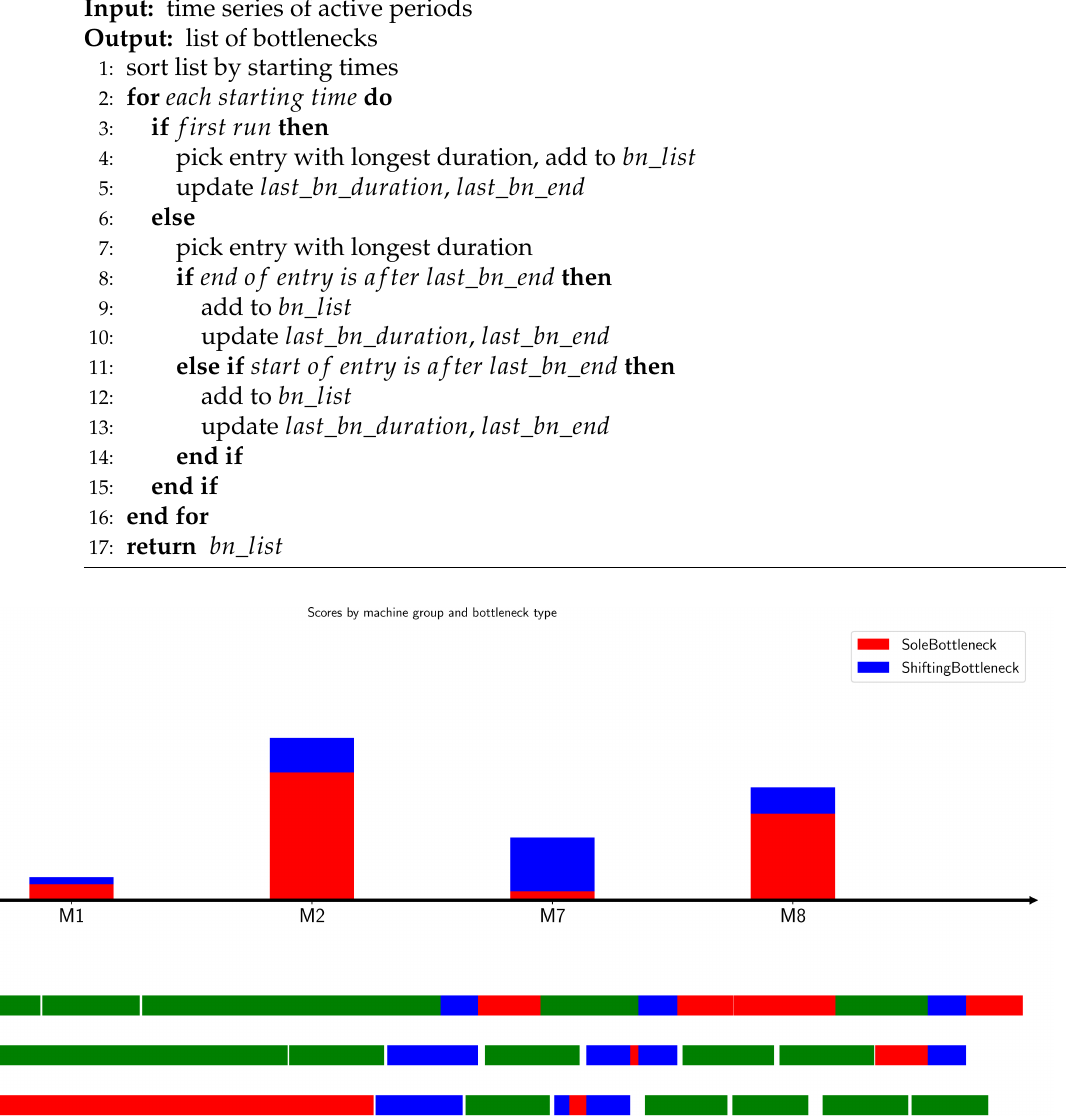
Algorithm 1 Algorithm for the Active Period Method